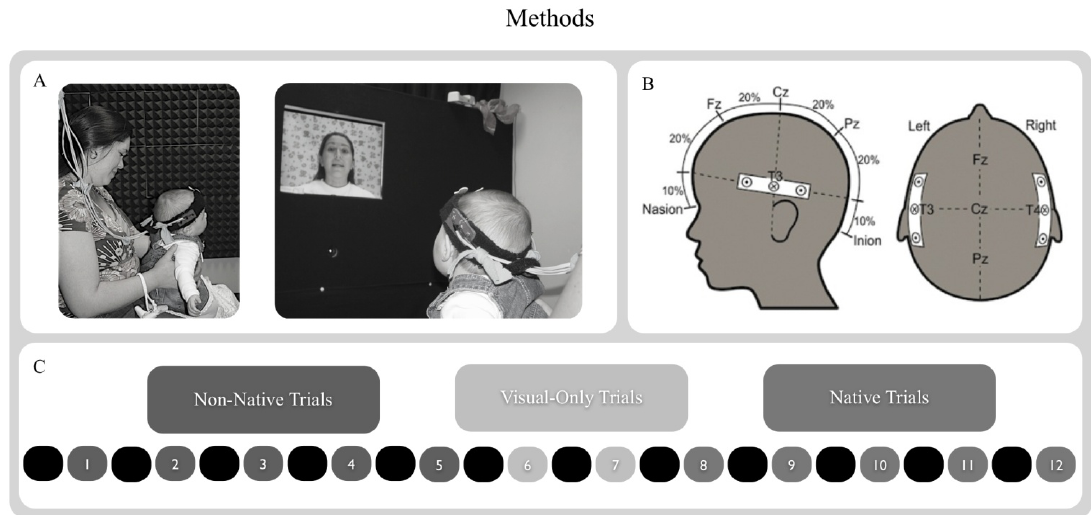
Figure 1. Methods. ( A ) Infants were exposed to speech stimuli while seated on a caregiver’s lap. ( B ) Infants wearing the NIRS headband, localized using the 10-20 coordinates T 3 and T 4 . ( C ) Infants were tested using a block-design that consisted of 20 s long stretches of non-native and native infant-directed audiovisual speech. Each trial was preceded by a 10 s silent baseline. The two types of audiovisual speech block were further separated by two 20 s long trials of animated shapes with no accompanying